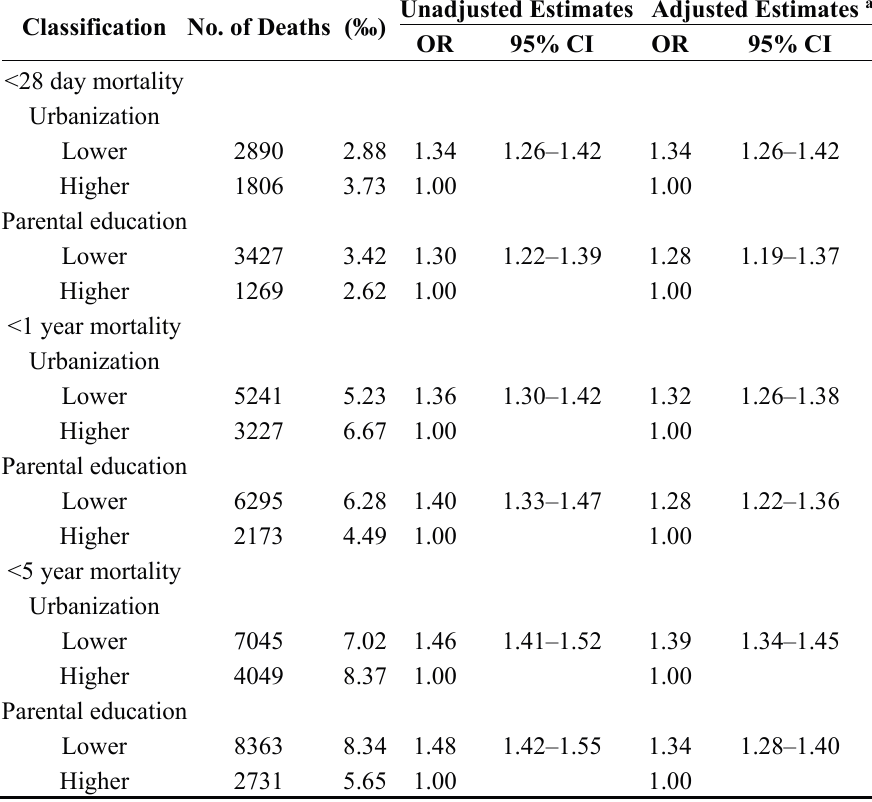
Table 2. Odds ratio of age-specific mortality according to urbanization or parental education. Unadjusted Estimates Adjusted Estimates a Classification No. of Deaths (‰) OR 95% CI OR 95%